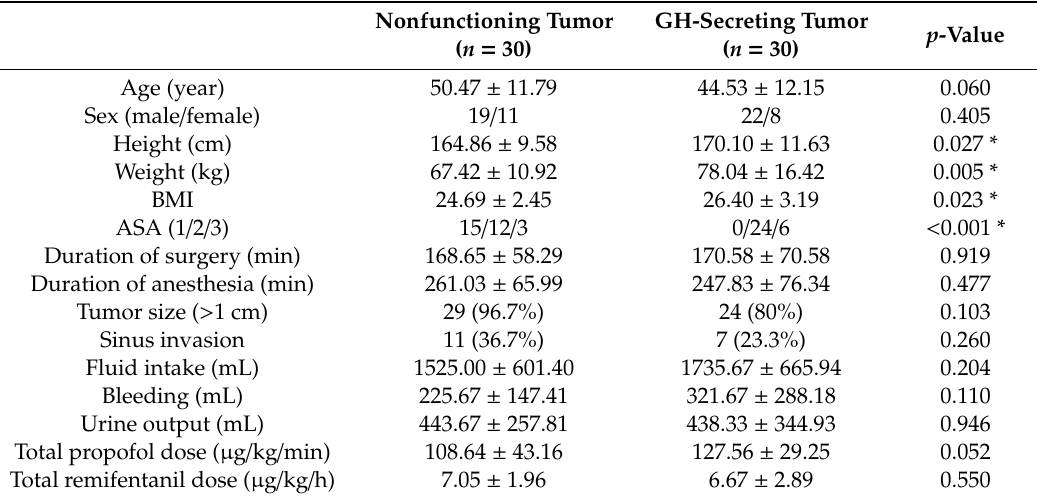
Table 1. Patient demographics and clinical data in this study.